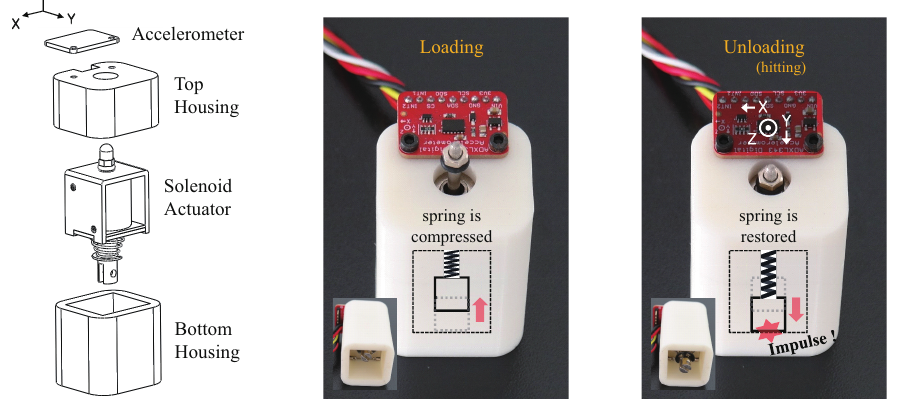
Figure 1. Prototype for knocking the surface and listening to the vibrations. We placed the solenoid actuator inside a 3D-printed housing and mounted an accelerometer on top of the housing. The coordinate system shown in the figure indicates the orientation of the accelerations.